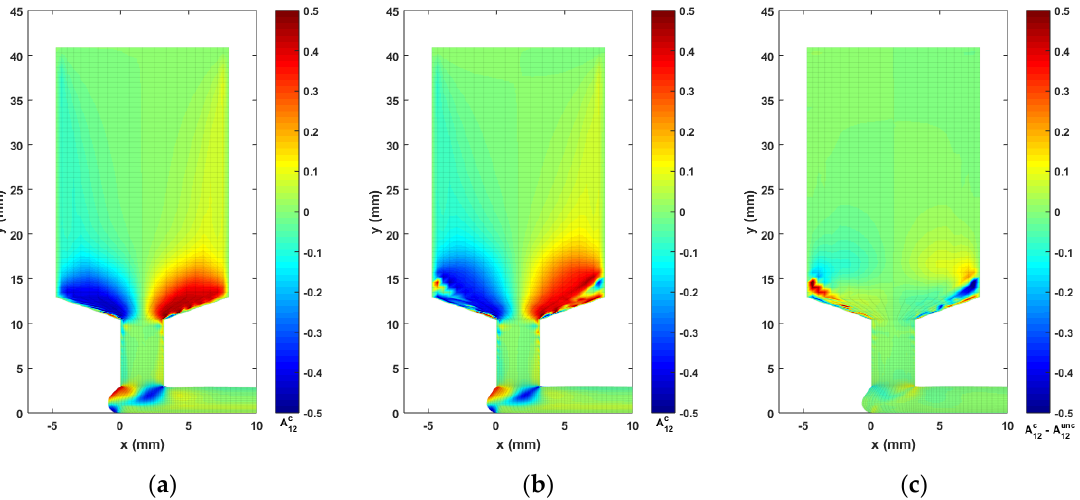
Figure 12. Fiber orientation tensor component contour of A 12 : ( a ) the uncoupled solution; ( b ) the fully coupled solution; ( c ) difference between the fully coupled and uncoupled solutions.